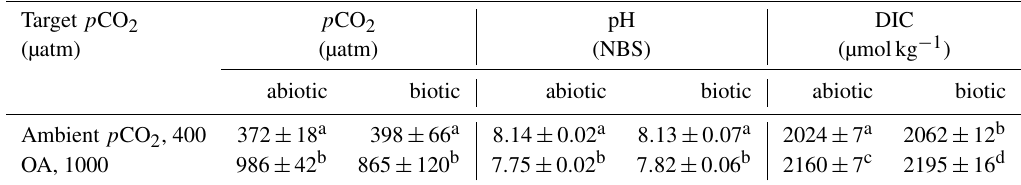
Table 1. Partial pressures of CO 2 ( p CO 2 ) for the ambient and ocean acidification (OA) treatments were calculated from measured pH, concentrations of dissolved inorganic carbon (DIC), silicate and phosphate, temperature, and salinity using the CO2Sys program (Pierrot et al., 2006). For all parameters, values are given for the abiotic control bottles (abiotic, bubbled seawater without cells) and the culture bottles at the end of the experiment (biotic). Different letters indicate significant differences between treatments ( p < 0 . 05). Values represent the means ± SD ( n =